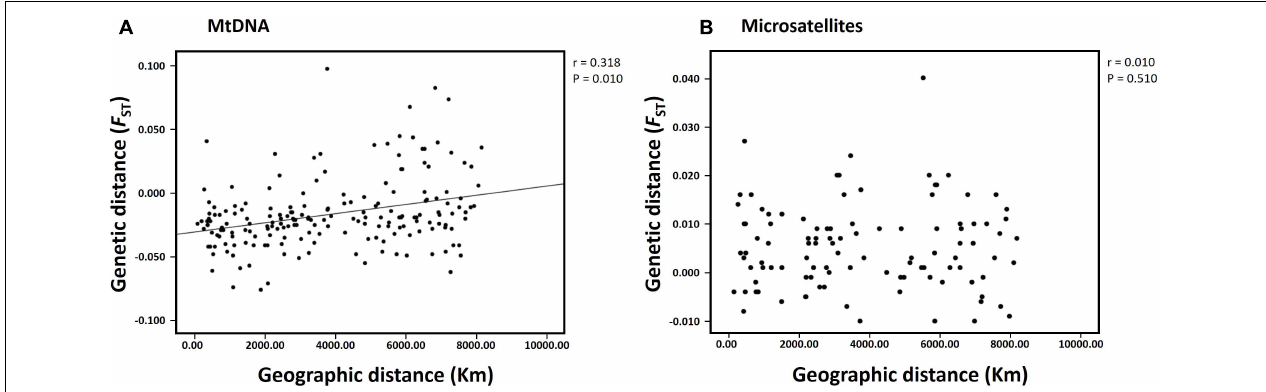
FIGURE 4 | Results of isolation-by-distance (IBD) analysis with the Mantel test for the populations of Dissostichus mawsoni in Subareas 58 and 88. (A) mtDNA (20 populations); (B) microsatellites (15 populations). The relationship between genetic ( F ST ) and geographic distances was statistically significant only for the mtDNA data set ( r = 0.318, P = 0.010).